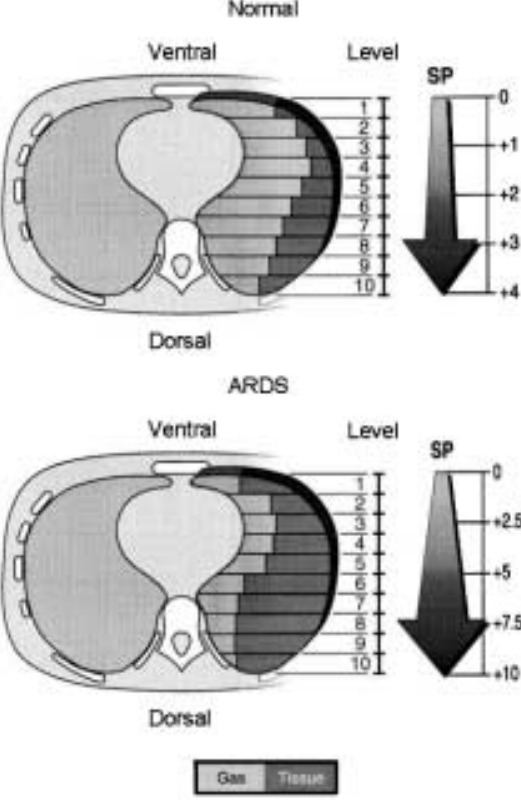
Figure 1 A schematic draw- ings of the relation- ship between CT number and lung